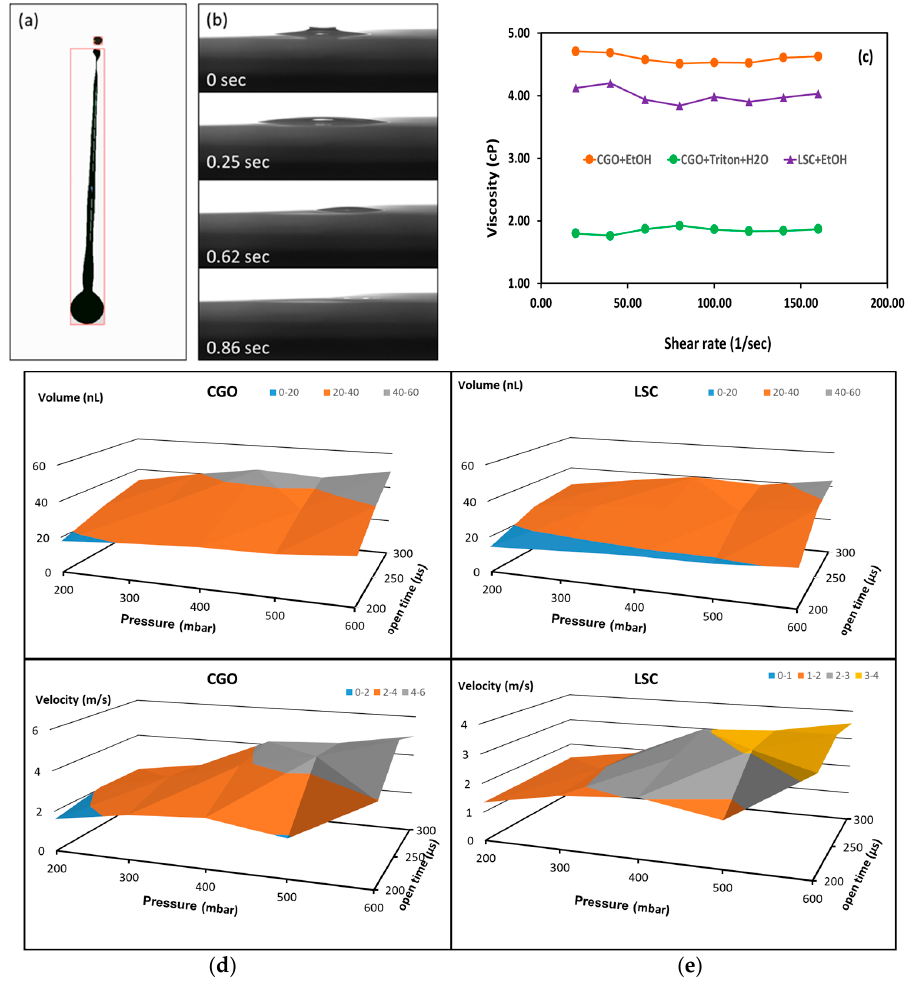
Figure 3. ( a ) Jetting behavior of CGO ink; ( b ) permeation dynamics of CGO ink drop infiltrated in LSCF scaffold; ( c ) viscosity measurements of both infiltrate inks (water-Triton X-100 based CGO ink viscosity data is presented for comparison) and volume/drop velocity dependences on printing parameters for both ( d ) CGO and ( e ) LSC inks.